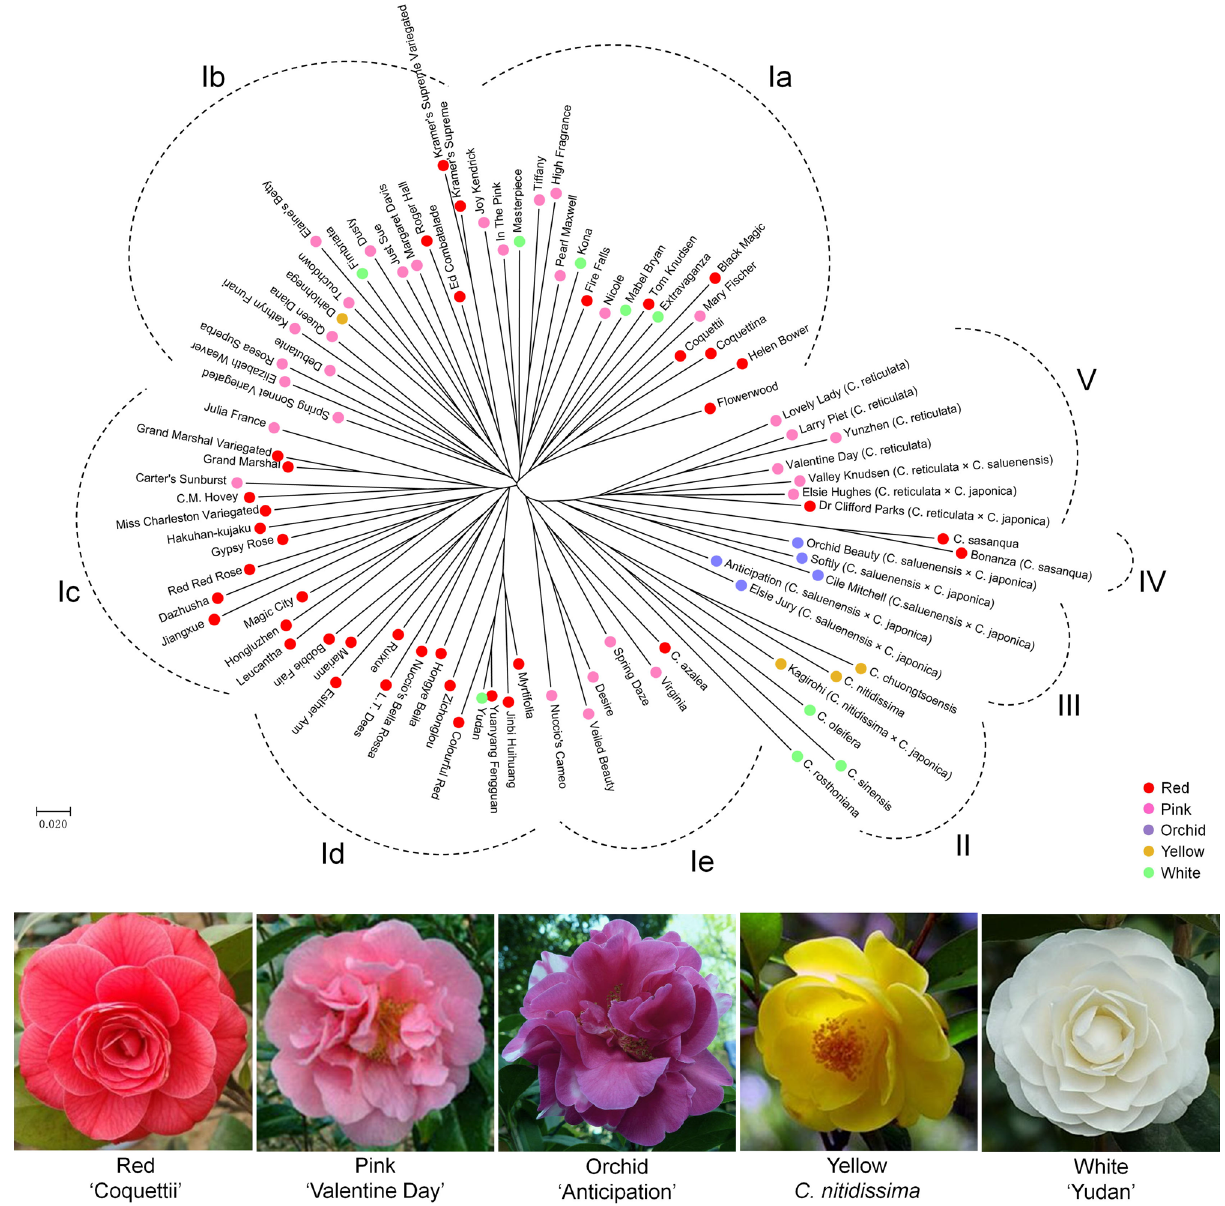
Figure 4. NJ dendrogram showing genetic relationships among the 89 camellia